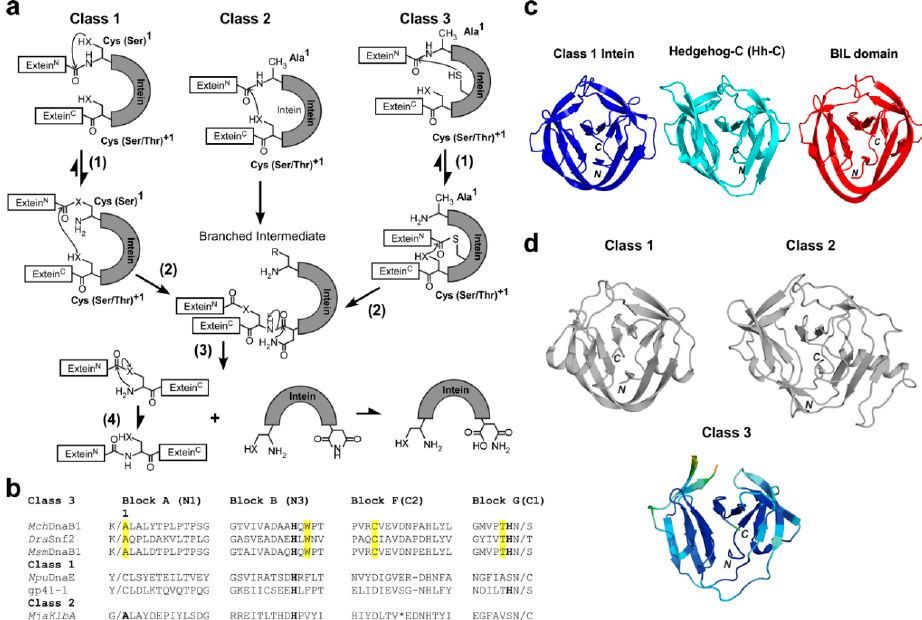
Figure 1. Protein splicing reaction steps for class 1, 2, and 3 inteins [8,9,12,14]. ( a ) Protein splicing mechanisms for class 1 inteins with four concerted steps: (1) N–X acyl shift (X = O or S); (2) Trans - (thio)-esterification; (3) Asn cyclization; (4) X–N acyl shift (X = O or S), for class 2 inteins: (2) Trans - (thio)-esterification; (3) Asn cyclization; (4) X–N acyl shift (X = O or S), and for class 3 inteins: (1) Thio- sequence alignment of class 1, 2, and 3 inteins for blocks A, B, F, and G. Highly conserved His residues